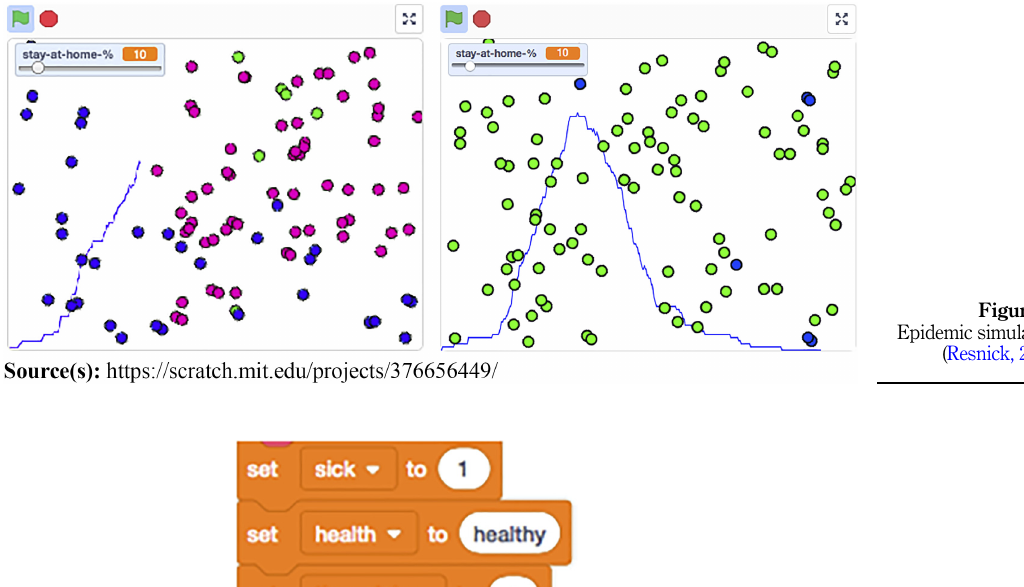
Figure 5. The parameters